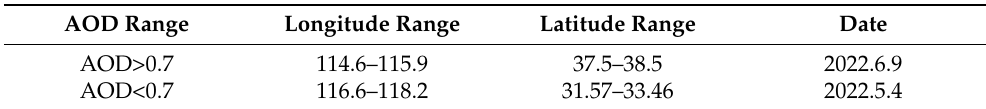
Table 4. Data information used for